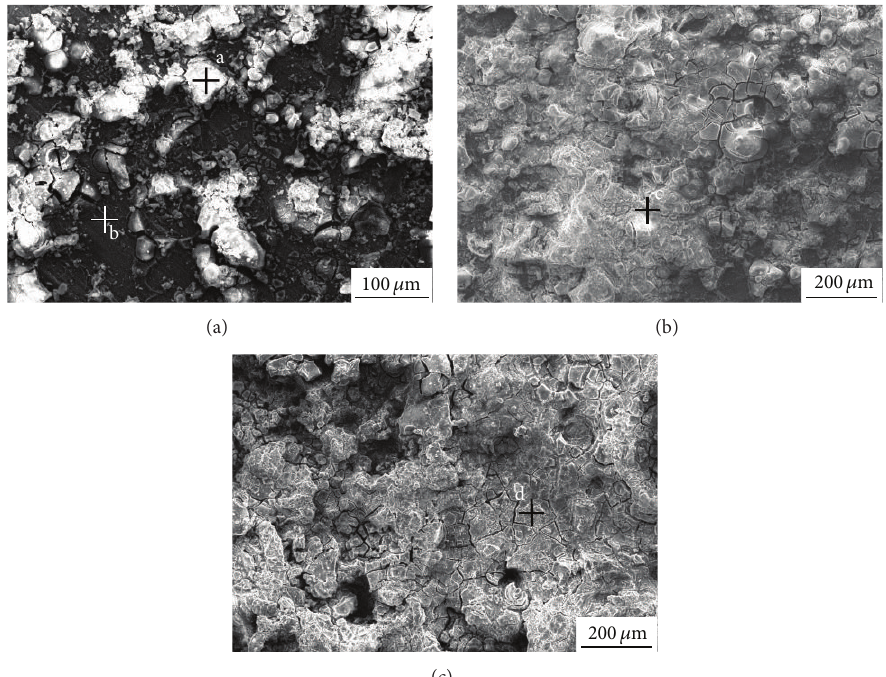
Figure 7: Surface morphology of the corrosion products formed on 2A12 aluminum alloy after exposure for 1 month (a), 12 months (b), and 48 months